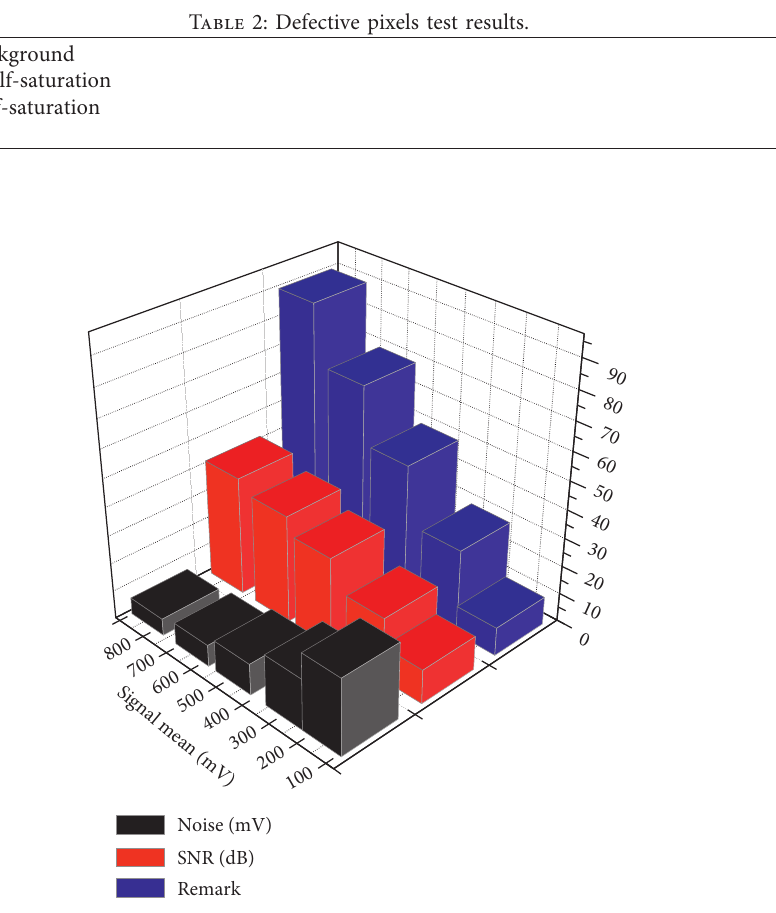
Figure 11: SNR test results.